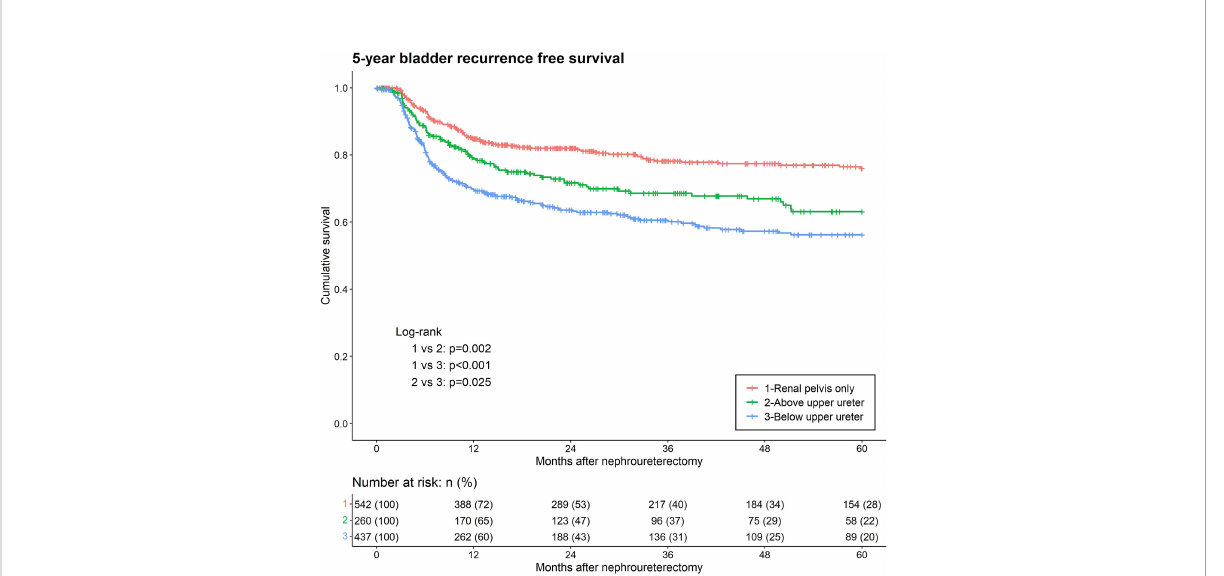
FIGURE 2 Kaplan-Meier analyses for 5-year intravesical recurrence-free survival strati fi ed by the lowest level of tumor involvement among patients with upper tract urothelial carcinoma following rad-ical nephroureterectomy.